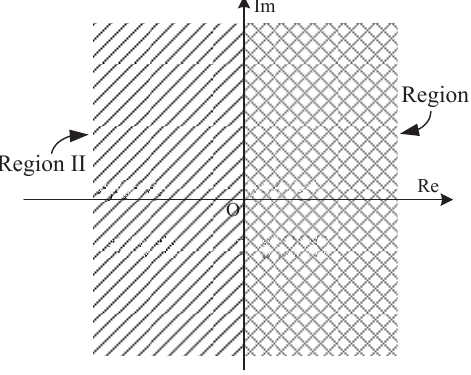
Figure 3. New division of the complex observation space.